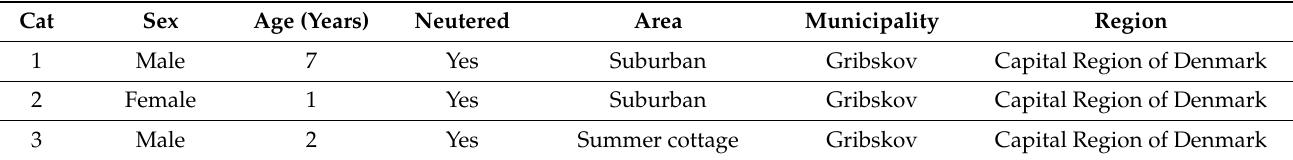
Table A2. Information about the cats involved in the GPS study on home range